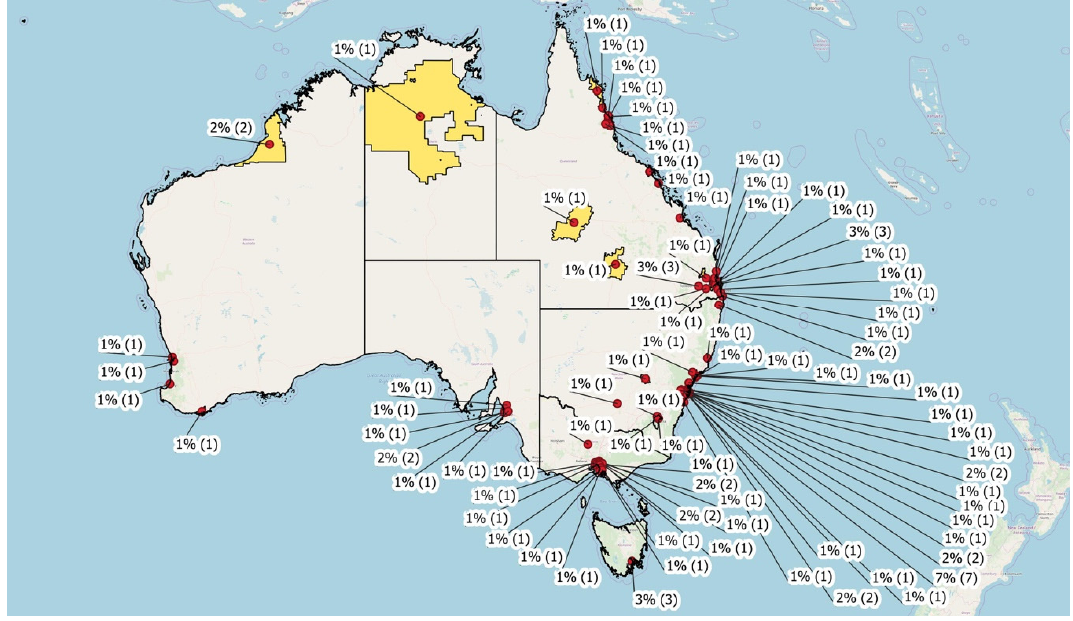
Figure 1. Geographical distribution of study respondents in Australia. Figure A1. Geographical distribution of study respondents in